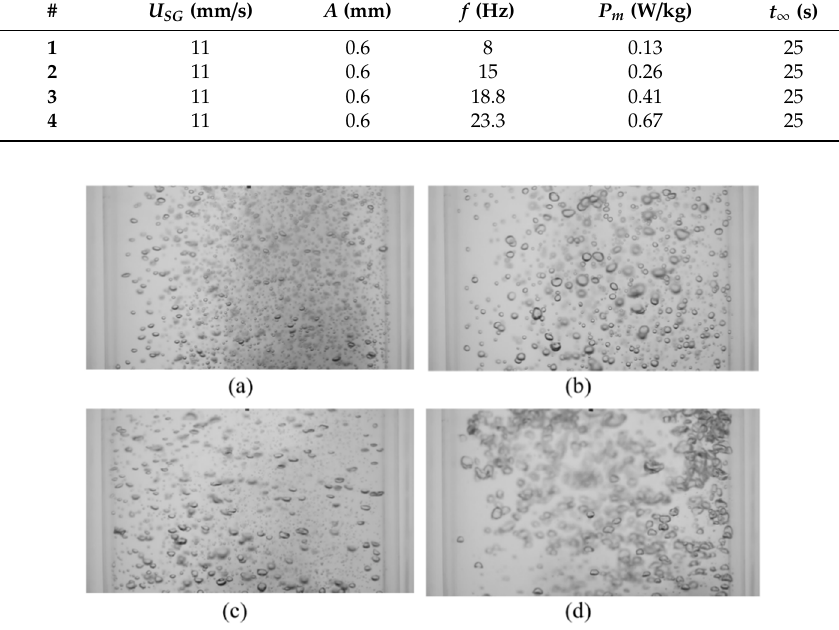
Figure 13. Instantaneous images of mixing at t = 8 s ( A = 0.68 mm, U SG = 11 mm / s) for ( a ) f = 8 Hz, P m = 0.136 W / kg; ( b ) f = 15 Hz, P m = 0.259 W / kg; ( c ) f = 18.8 Hz, P m = 0.406 W / kg; ( d ) f = 23.3 Hz, P m = 0.667 W / kg.